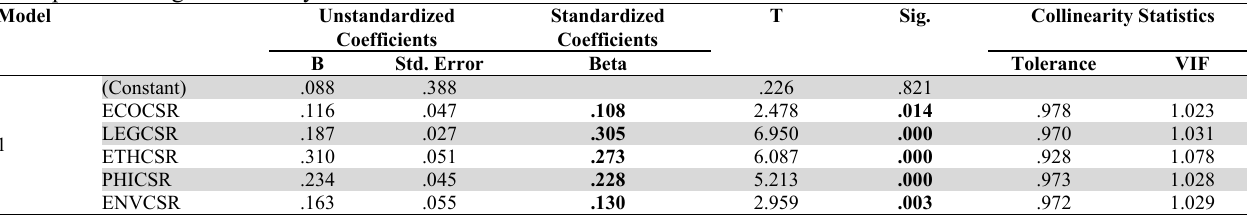
Multiple linear regression analysis